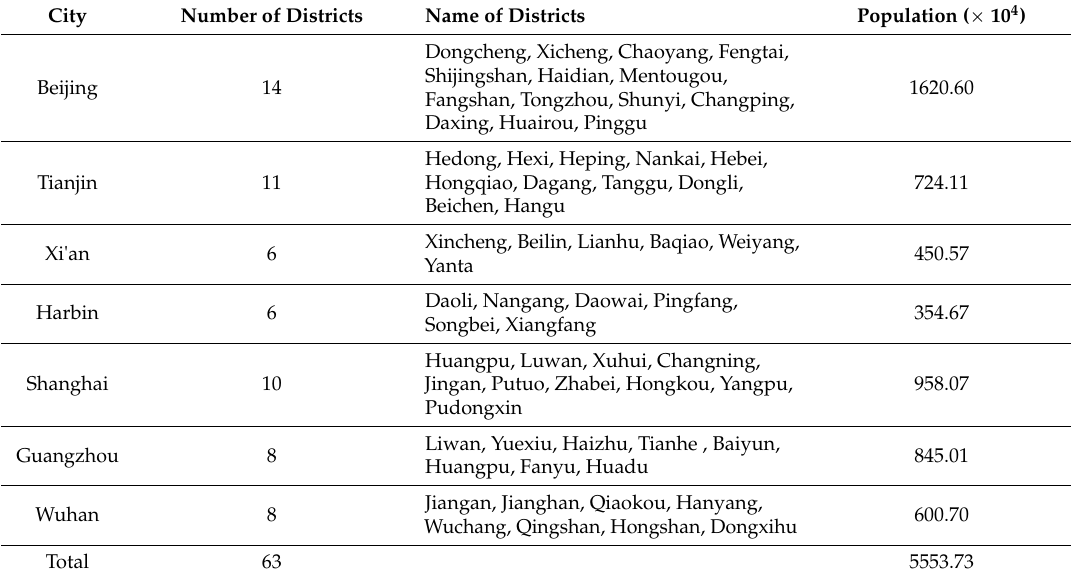
Table 1. Summary description of the population and the districts of seven large cities in China.